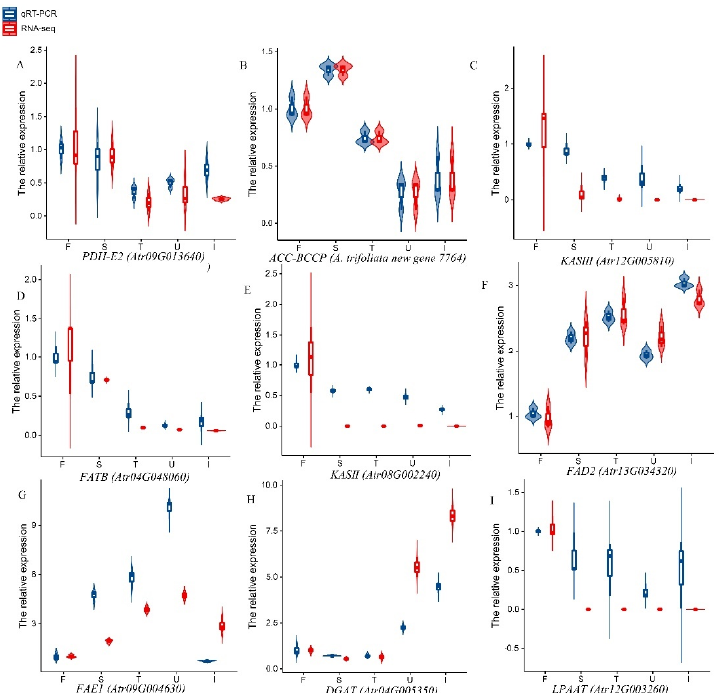
Figure 5. qRT-PCR analysis of nine important genes associated with lipid biosynthesis. The expression of all genes was normalized: blue and red represent qRT-PCR and RNA-seq expression levels, respectively. ( A ) The relative expression level of PDH-E2. ( B ) The relative erpression level of ACC- BCCP . (C) The relative erpression level of KAS Ⅲ. ( D ) The relative erpression level of FATB. ( E ) The relative erpression level of KAS Ⅱ . ( F ) The relative erpression level of FAD2. ( G ) The relative erpression level of FAE1. ( H ) The relative erpression level of DGAT . ( I ) The relative erpression level of LPAAT